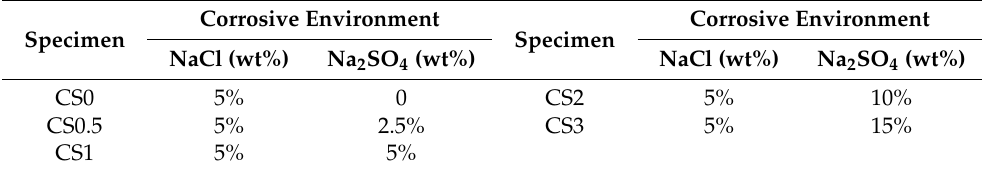
Table 3. Corrosion conditions of